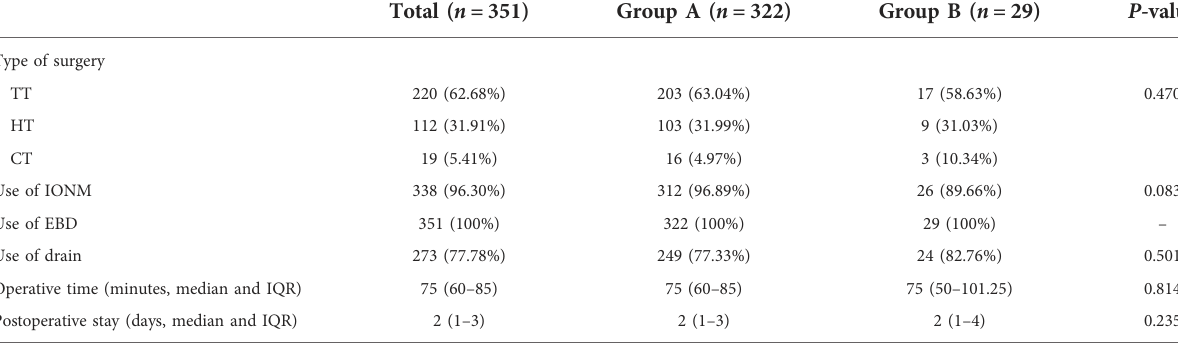
TABLE 2 Information about the surgical procedure and postoperative stay.